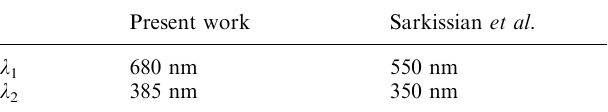
Table 1. Wavelengths used for calculation of the CI Present work Sarkissian et al.